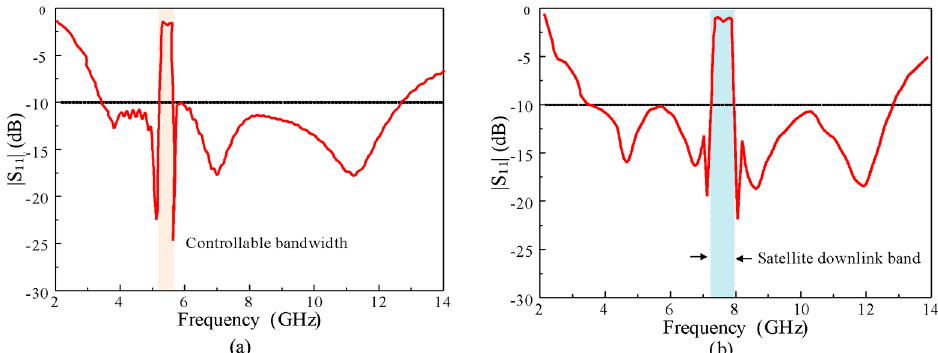
Figure 12. Demonstration of controllable notch band of the proposed antenna: ( a ) bandwidth and ( b ) frequency.